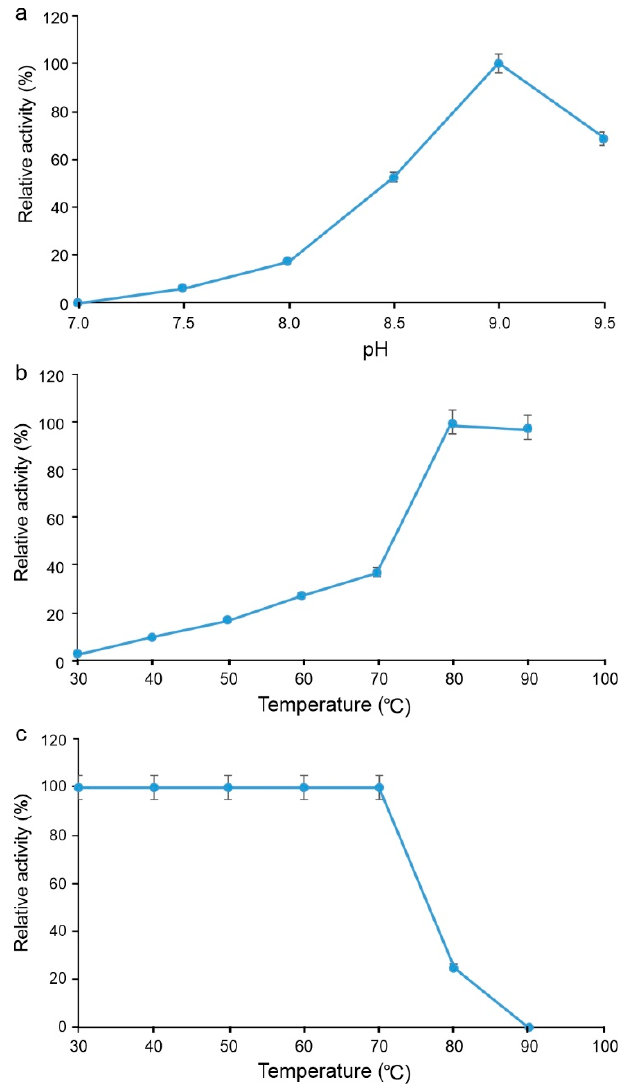
Figure 4. The influence of pH ( a ) and temperature ( b ) on Sbv333-TA activity and influence of temperature ( c ) on Sbv333-TA stability. Values are means of two independent experiments ± standard deviations (SD).